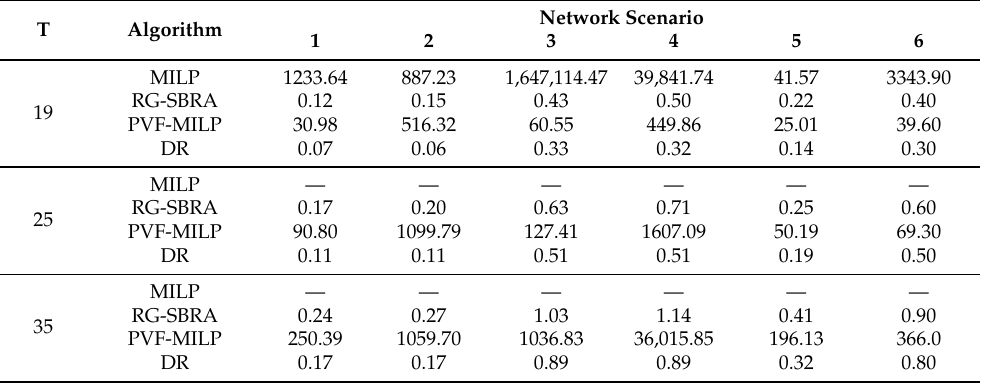
Table 6. Execution time (in